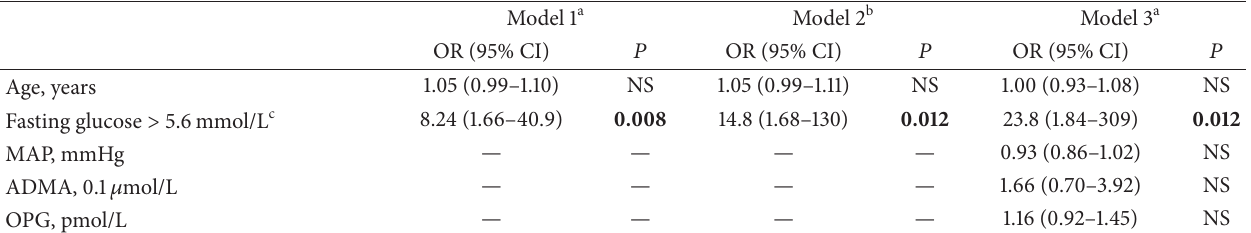
Table 3: Multiple logistic regression models to study the associations of the selected variables with vascular calcifications as assessed by alizarin red staining of the radial